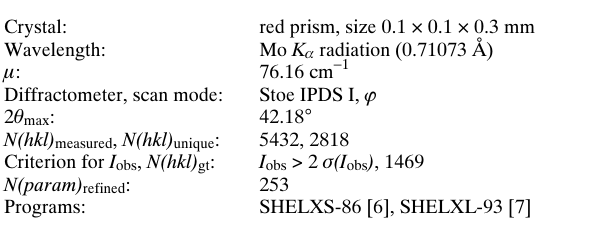
Table 4. Data collection and handling.